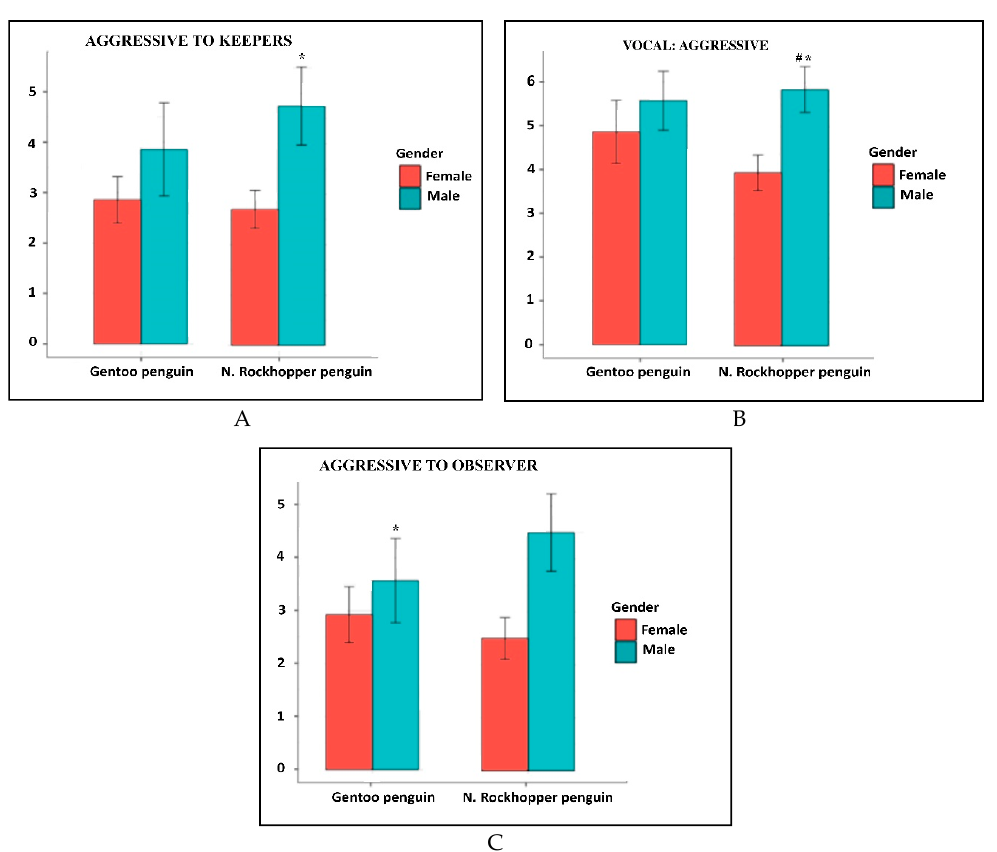
Figure 2. Graphic representation of the traits that presented statistically significant differences between males and females. In ( A ) Aggressive to keepers; in ( B ) Vocal: aggressive; in ( C ) Aggressive to observer. p < 0.05 values are considered as statistically different. * = male vs. female; # = gentoo vs. northern rockhopper.